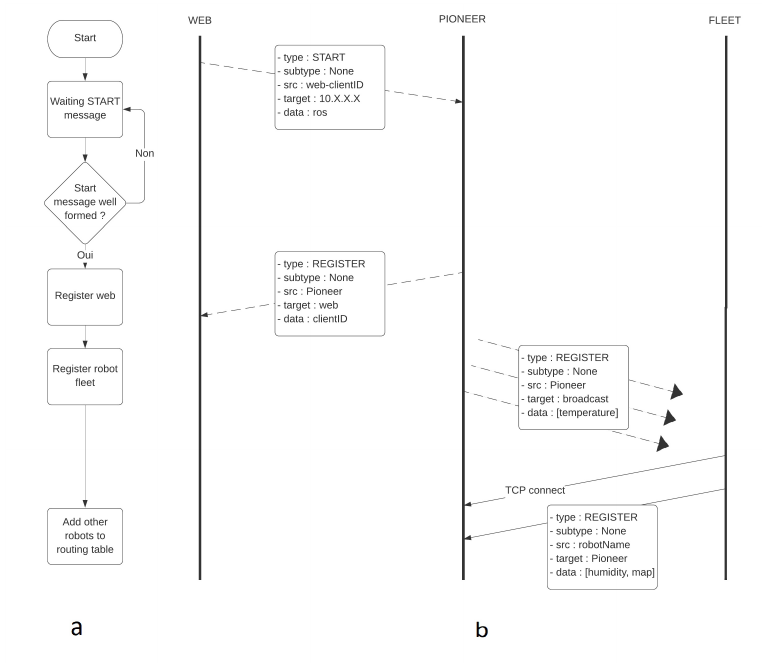
Figure 2. Procedure to register a new robot into the